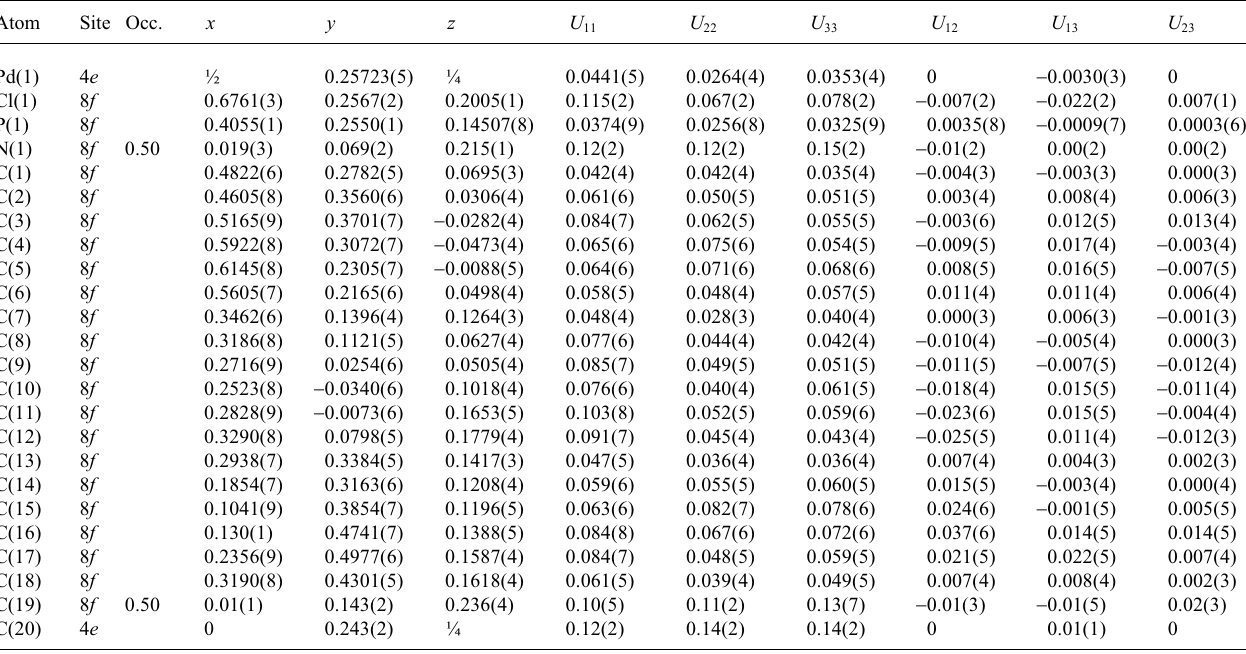
Table 3. Atomic coordinates and displacement parameters (in Å 2 ) . Atom Site